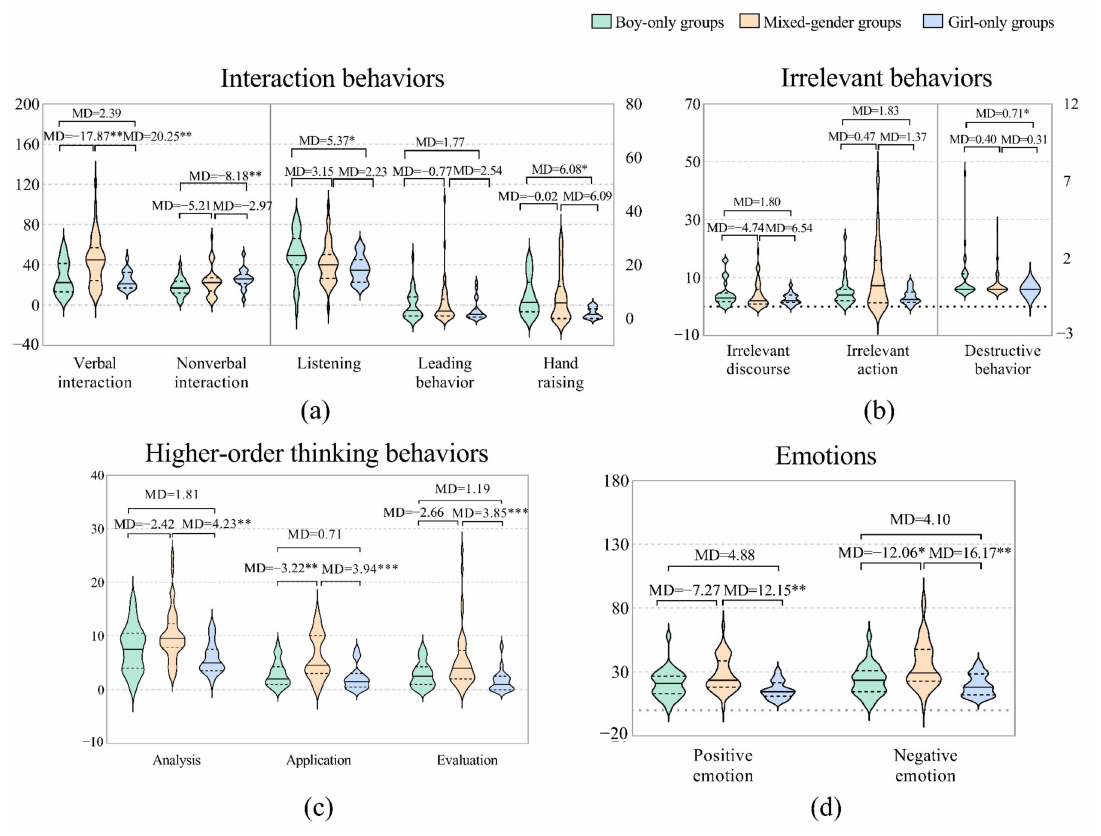
Figure 3. Differences in gender groups. ( a ) Interaction behaviors: the frequencies of verbal and nonverbal interactions are reflected on the left Y axis; the frequencies of behaviors of listening, leading, and hand raising are reflected on right Y axis. ( b ) Irrelevant behaviors: the frequencies of irrelevant discourse and irrelevant action are reflected on the left Y axis, and the frequency of destructive behavior is reflected on the right Y axis. ( c ) Higher-order thinking behaviors: the frequencies of analysis, application, and evaluation behaviors. ( d ) Emotions: the frequency of positive emotions and negative emotions. Note: *: p < 0.05; **: p < 0.01; ***: p <